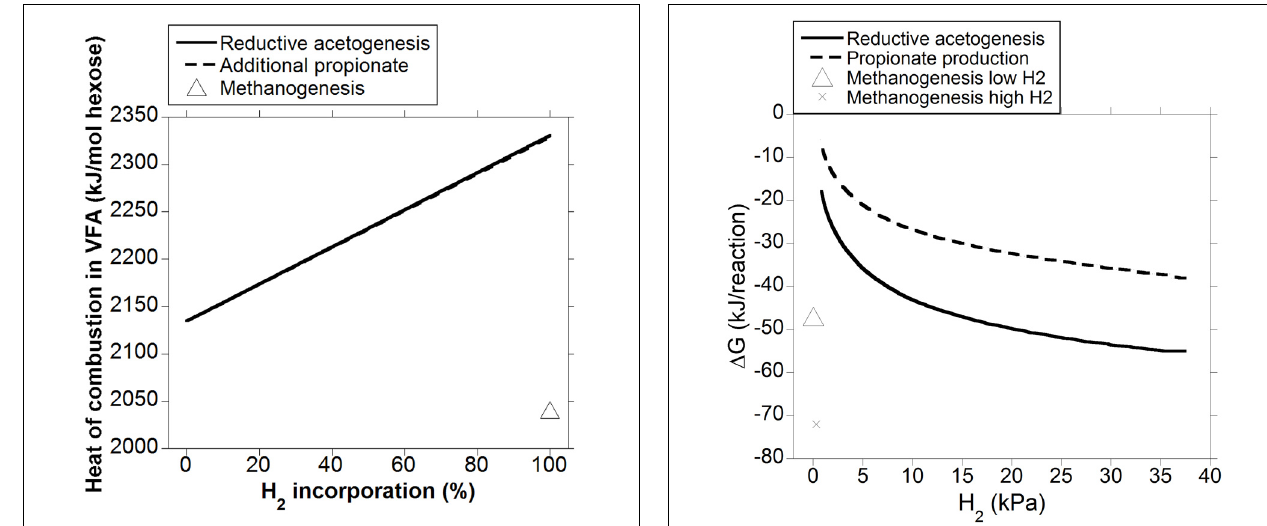
FIGURE 6 | Estimated (cid:2) G for reductive acetogenesis or additional propionate formation as a function of H 2 incorporation. Corresponding fermentation with CH 4 as main electron sink is provided as